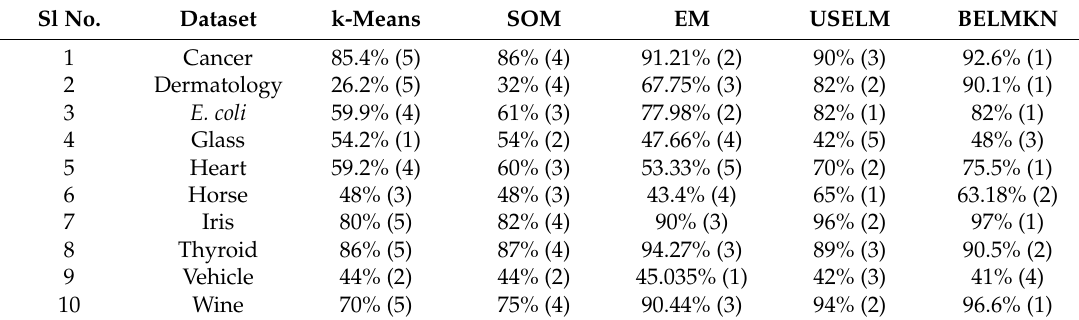
Table 3. Clustering accuracy percentage and ranking of various techniques on each dataset. Sl